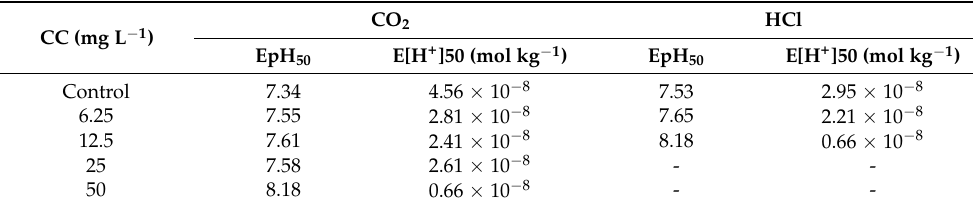
Table 4. Values of EpH 50 and E[H + ]50 for the experimental